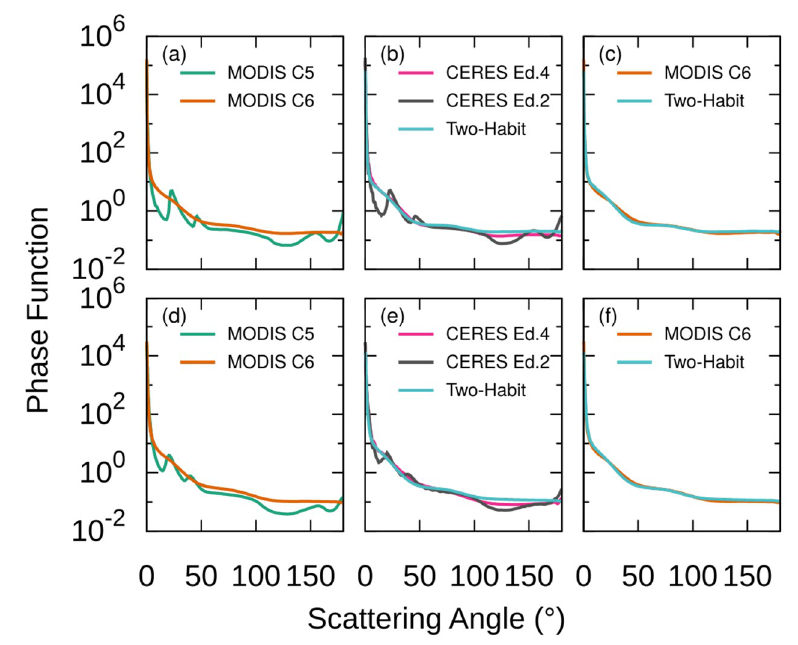
Figure 12. Comparison of the phase functions at wavelength 0.86 μm based on: ( a ) MODIS Collection 4, 5, and 6; ( b ) CERES Edition 2 and 4, and the two-habit model; and ( c ) MODIS Collection 6 and the two-habit model. ( d – f ) Counterparts of ( a – c ) at wavelength 2.13 μm. Effective radius is fixed at 30 μm.